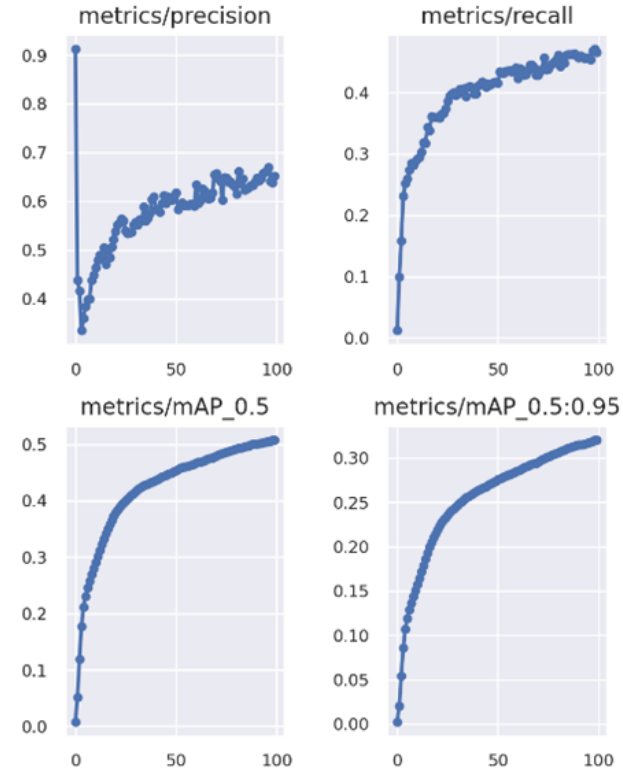
Figure 18. Training on the SEAGULL and COCO combination—progress of metrics during the 100